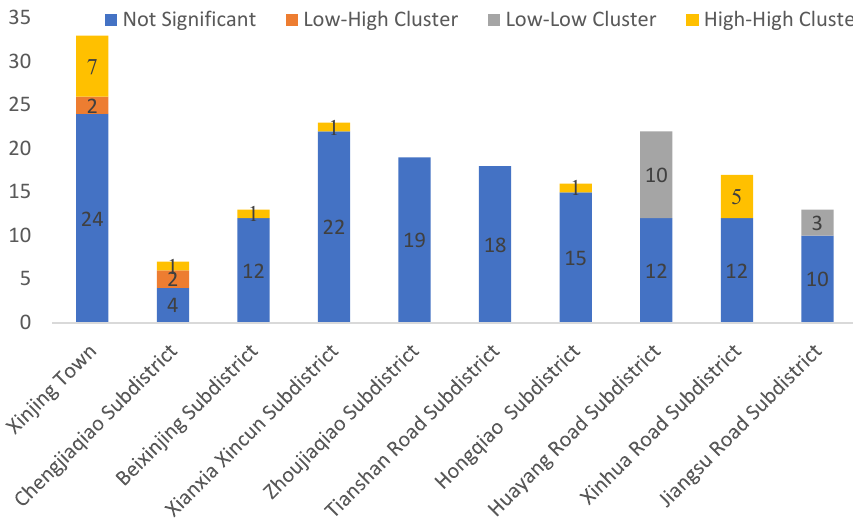
Figure 8. Number of communities with different types of clustering.